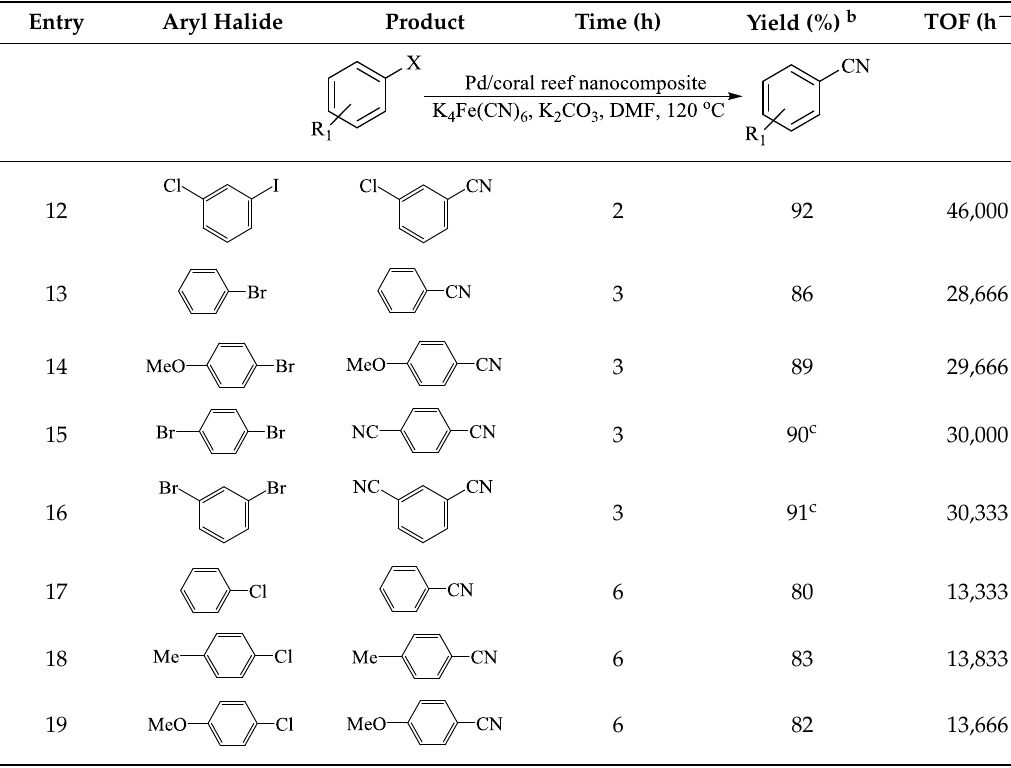
Table 2. Cont. Table 2. Cyanation of aryl halides with K 4 Fe(CN) 6 in the presence of the Pd/coral reef nanocomposite a .